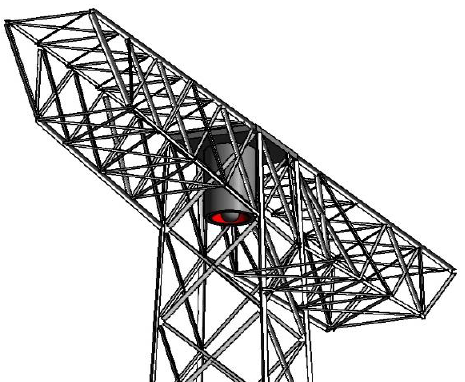
Figure 9. Layout of the SPPTMD on the transmission tower.